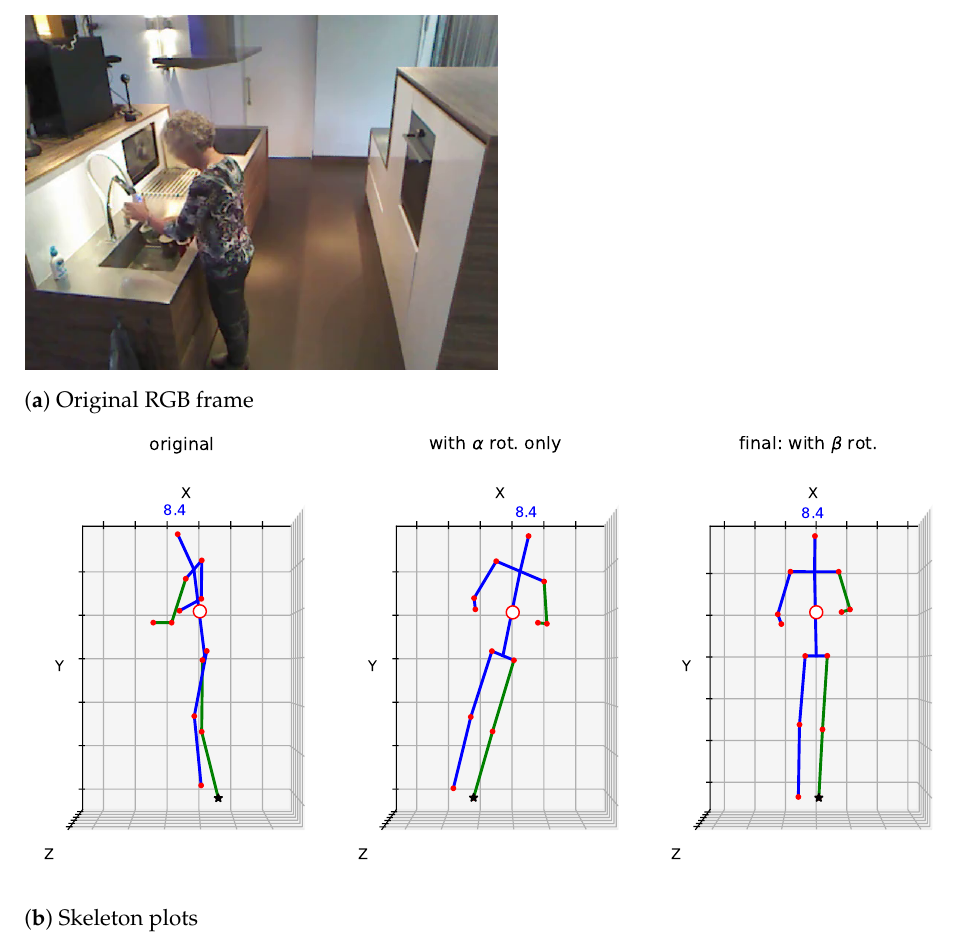
Figure 2. Proposed skeleton rotation at different stages. ( a ) shows the original video frame; ( b ) left: original skeleton as detected by LCR-Net, centre: skeleton rotated about the Y axis (intermediate step), right: skeleton fully rotated also about the Z